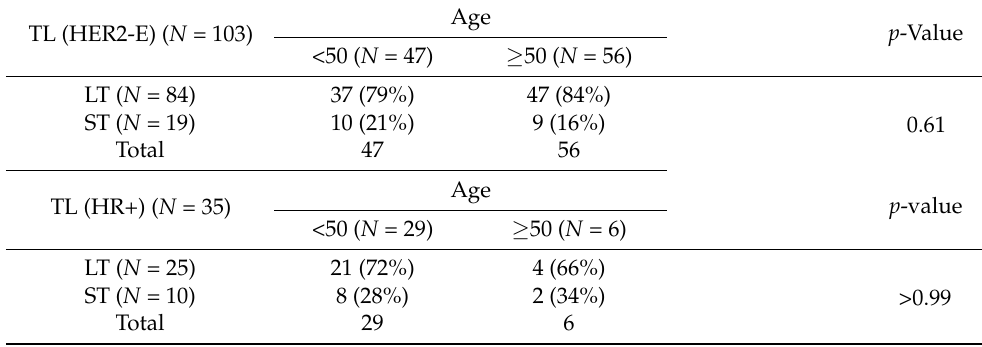
Table 5. Significant evaluation between the length of the telomeres with the clinical